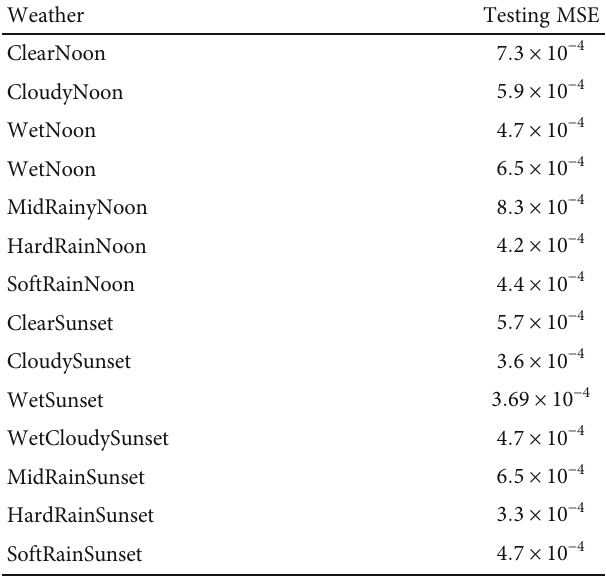
Table 4: Test root mean squared of proposed model on various weather conditions.